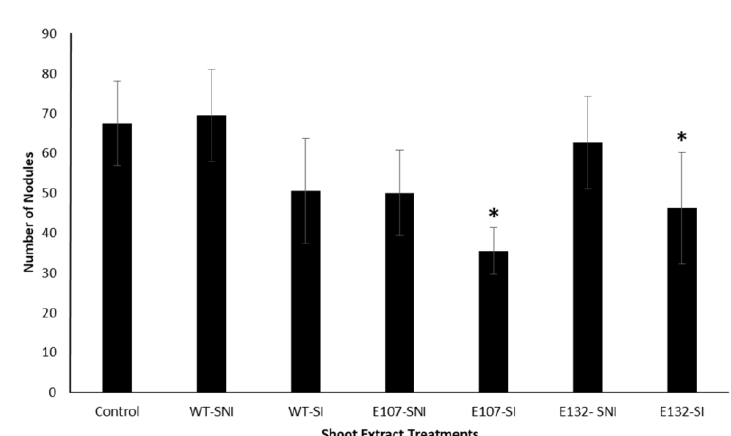
Figure 3. The e ff ect of shoot extracts on WT nodulation. Inoculated WT plants were treated with the extracts derived from shoots of WT, E107, or E132 plants, inoculated (SI) or not (SNI) with rhizobia. Water was used as the control treatment. Nodules were counted at 21 DAI. Values represent means ± standard errors, n = 15. An asterisk denotes significant di ff erences to the